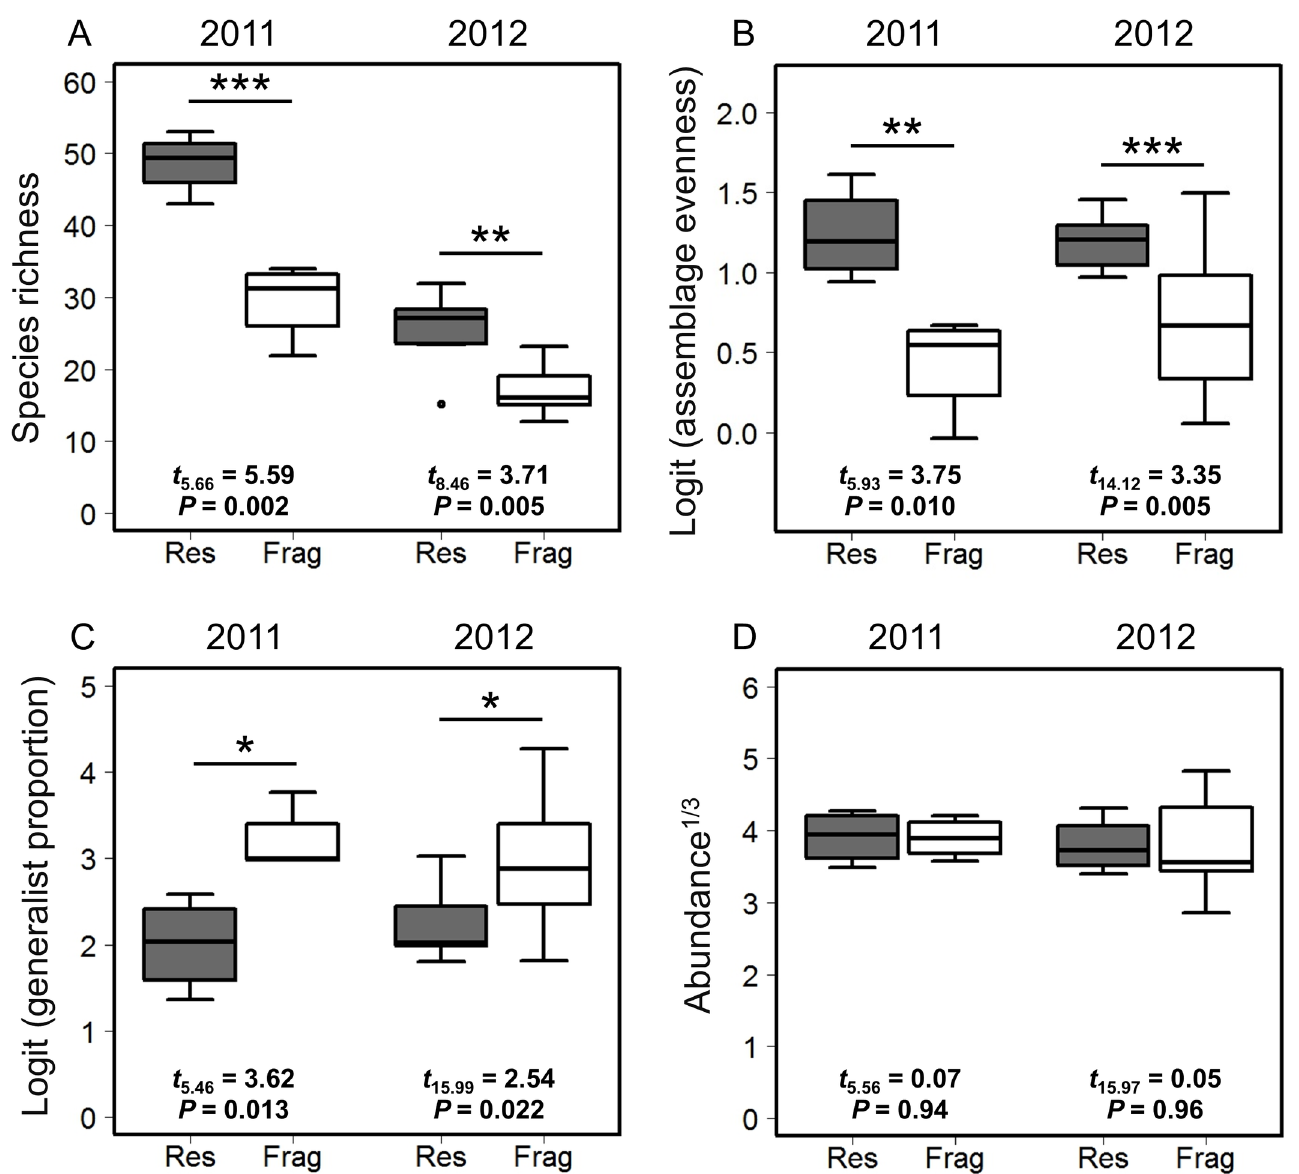
Fig 2. Temporal gamma diversity of native bees in reserve(gray boxes) and fragment plots (white boxes). Box and whisker plots show (A) rarefied species richness, (B) logit-transformed rarefied assemblage evenness(Pielou’s J ), (C) logit-transformed proportionof individuals belonging to generalistspecies, and (D) cube root-transformed averagenumber of bees collectedper temporal sample. Boxes show central 50% of data and median;whiskers show quantiles ± interquartile range × 1.5, or most extreme values of data, whichever is closest to median;and circles denote outliers. * P < 0.05, ** P < 0.01, *** P < 0.005.